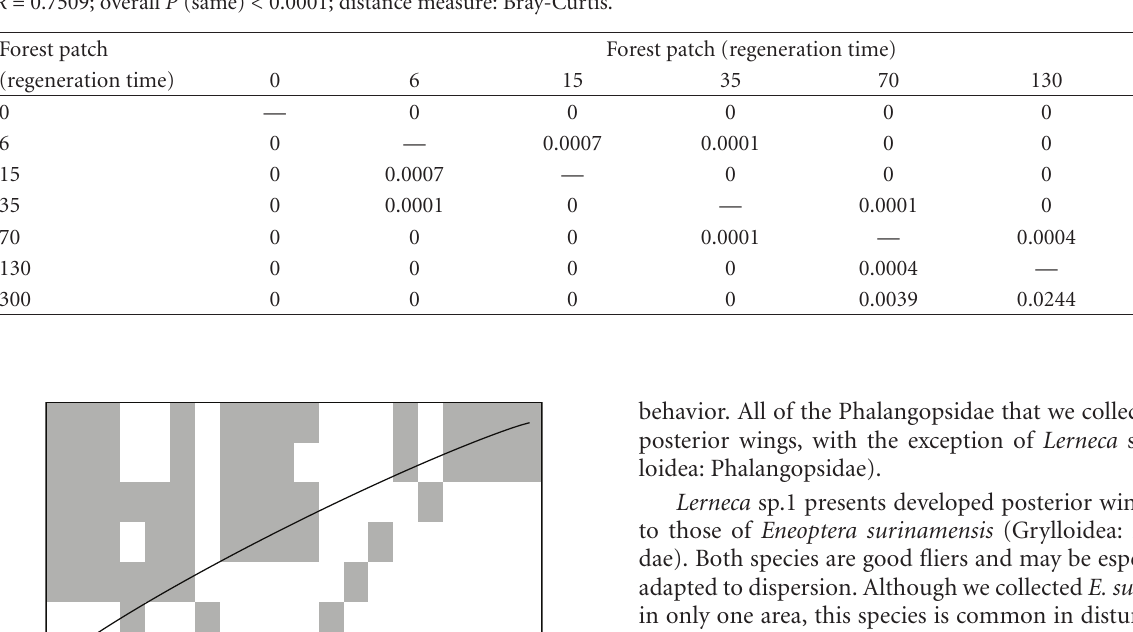
Table 3: Analysis of similarity (ANOSIM) results, showing, Bonferroni-corrected P values for the null hypotheses that forest patch species composition is the same for each patch combination. Permutation number = 10,000; mean rank within = 419.6; mean rank between = 1326; R = 0.7509; overall P (same) < 0.0001; distance measure: Bray-Curtis.